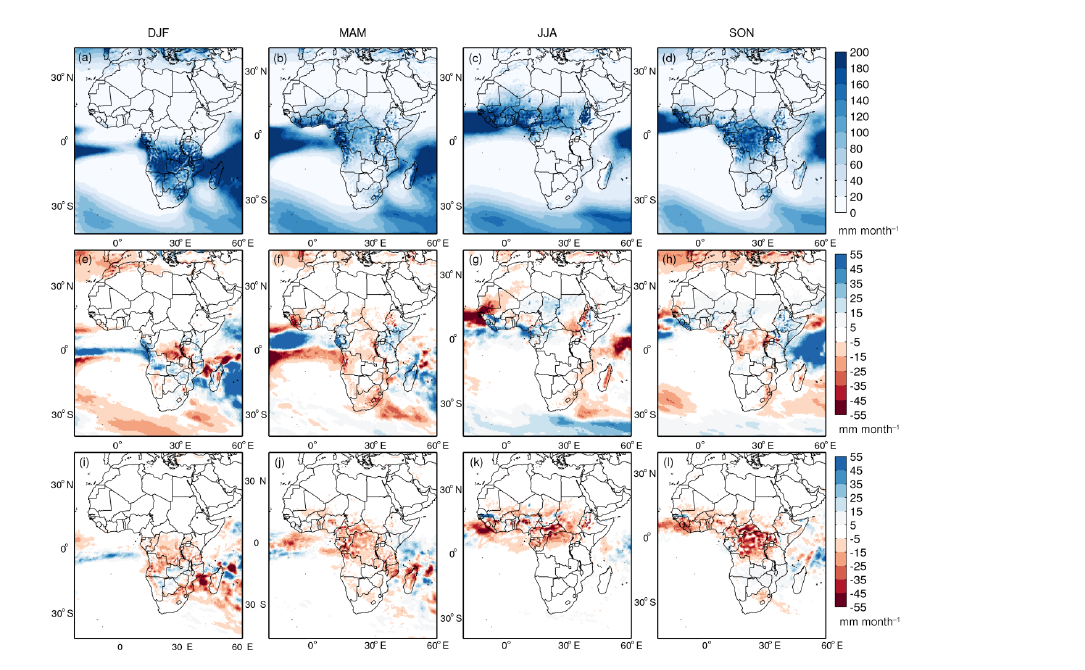
Figure A4. Similar to Fig. A3 but for